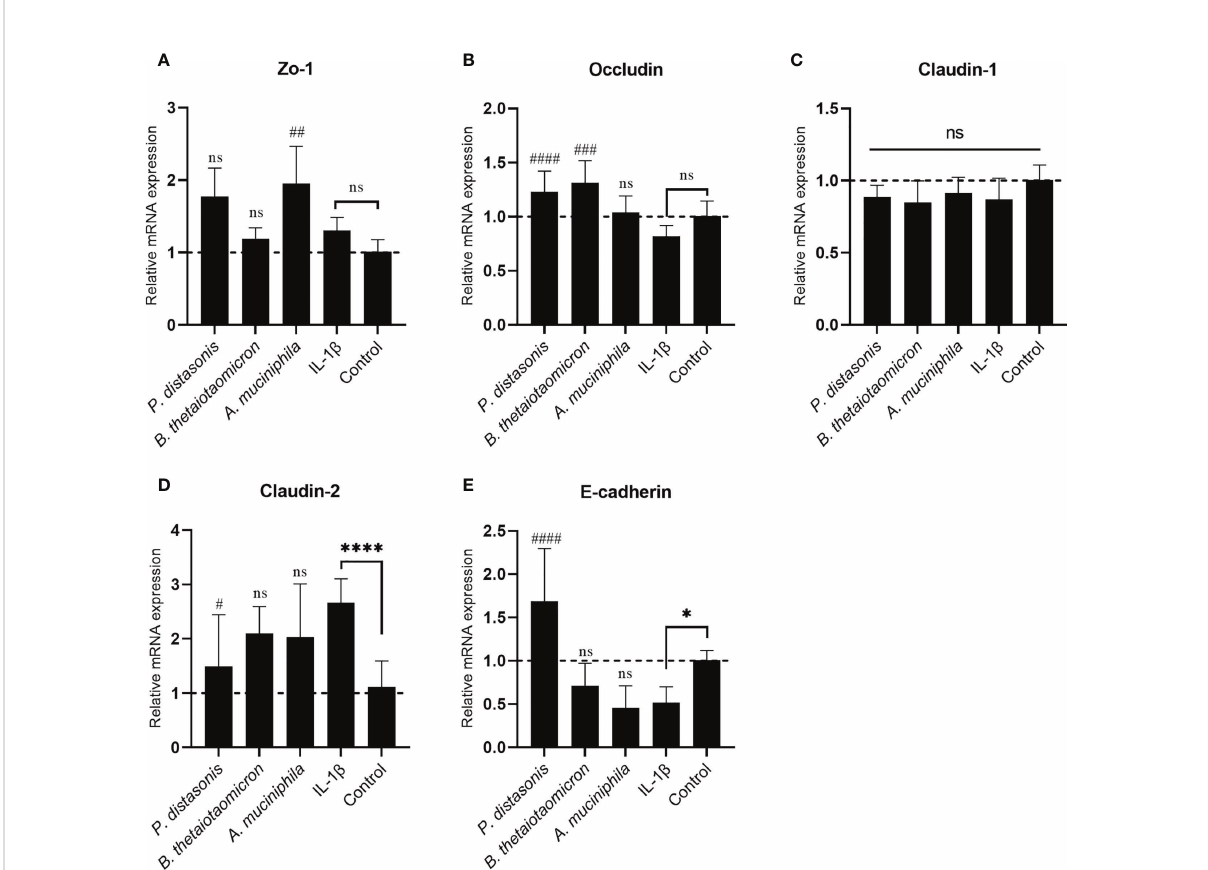
FIGURE 7 Co-culture with P. distasonis, B. thetaiotaomicron and A . muciniphila restored the IL-1 b induced dysregulation of intestinal TJ protein genes ’ mRNA expression. Caco-2 cell monolayers co-incubated with gut commensals were followed by stimulation by IL-1 b (10 ng/mL). Cells without any treatment were used as a control. The mRNA expression of TJ protein Zo-1 (A) , Occludin (B) , Claudin-1 (C) , Claudin-2 (D) and E-cadherin (E) were measured by qPCR. Cells without any treatment were used as a control. *p < 0.05, ****p < 0.0001 IL-1 b vs. control, ns: no signi fi cant. #p < 0.05, ##p < 0.01, ###p < 0.001, ####p < 0.0001 IL-1 b vs. treated groups. Error bars represent the standard deviation of the mean values from at least three replicates. Signi fi cance was determined by one-way ANOVA followed by Dunnett ’ s test for multiple